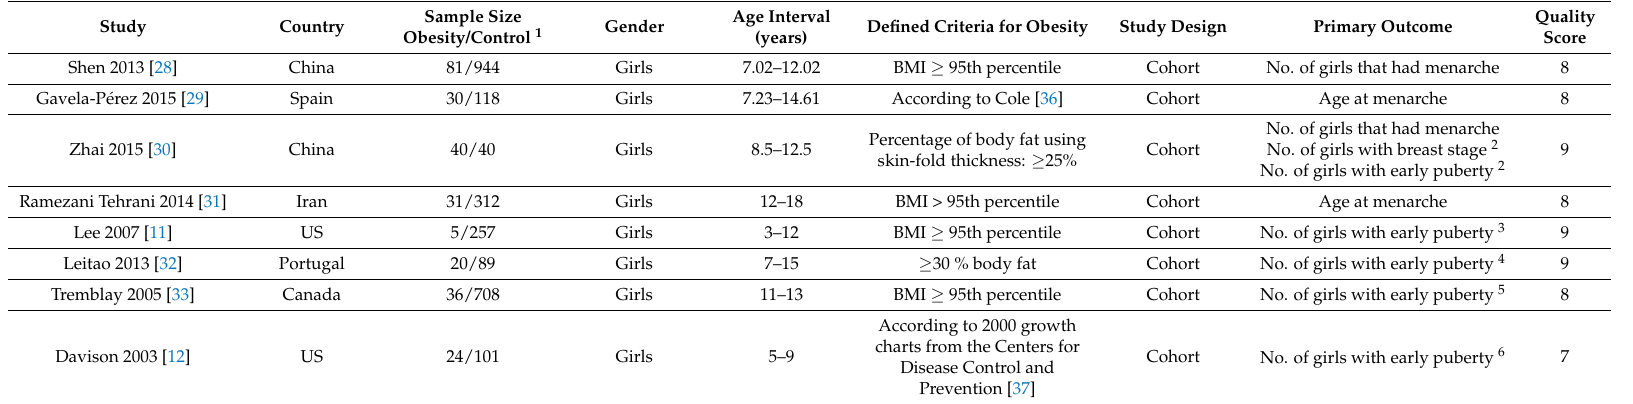
Table 1. Characteristics of studies included in the meta-analysis.